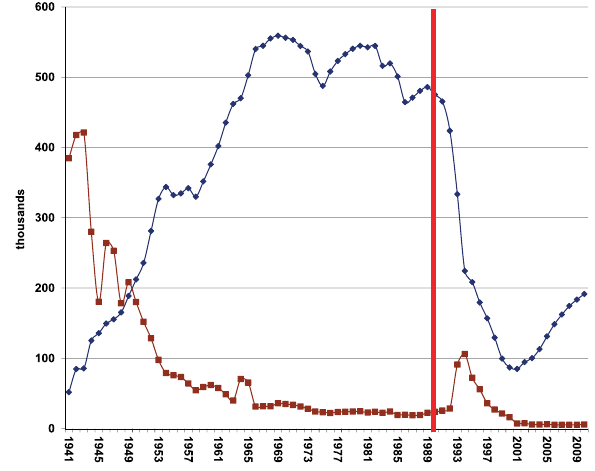
Fig. 6. A comparision of reindeer